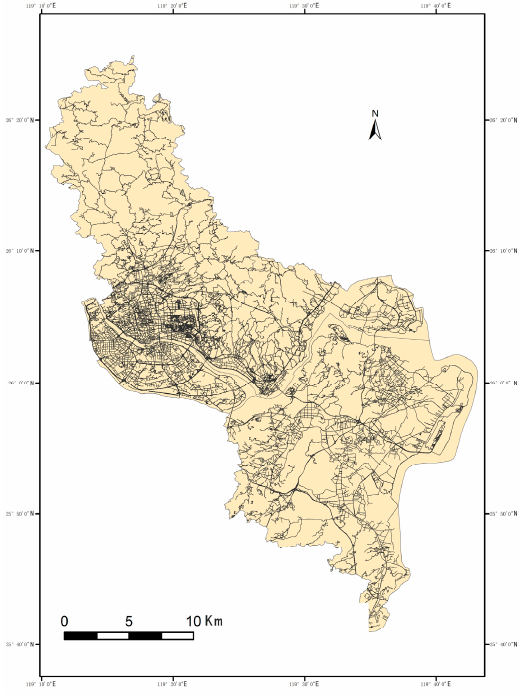
Figure 4. Road network data of Fuzhou City in 2022.